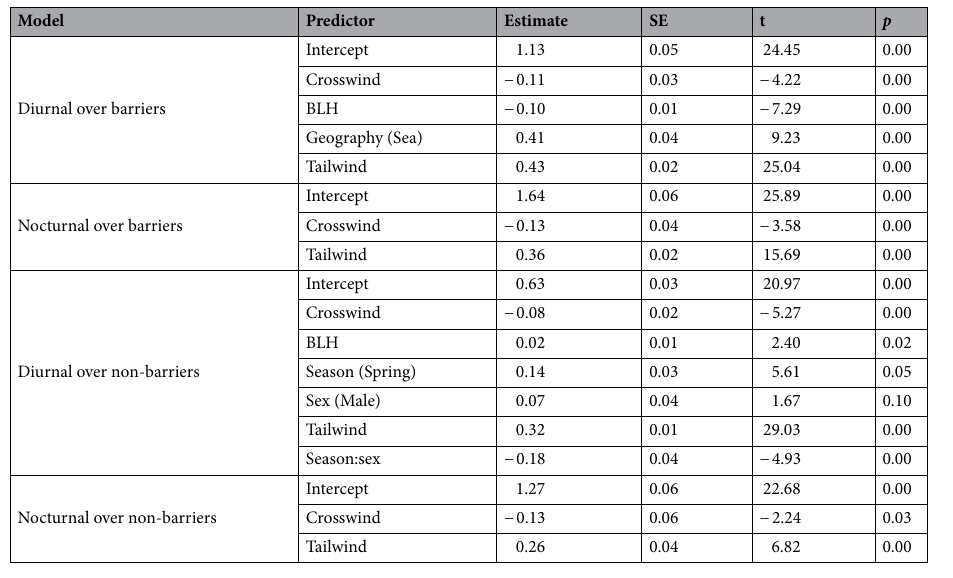
Table 3. Estimates for fixed effects at the hourly scale as estimated by the most parsimonious model during diurnal migration over barriers (sample size = 2,966), nocturnal migration over barriers (sample size = 1,819), diurnal migration over non-barriers (sample size = 6,373) and nocturnal migration over non-barriers (sample size = 1094). Boundary layer height (BLH) serves as a proxy for the availability and strength of thermal uplifts; thus, we only included BLH in diurnal models. Model estimates in units of standard deviation (SD) (organised from higher to lower relative importance), standard errors (± SE) and the t-value (the ratio between the estimate and its SE) are given. All models included individual identity (ID) as a random effect. (* p ≤ 0.05; ** p ≤ 0.01; *** p ≤